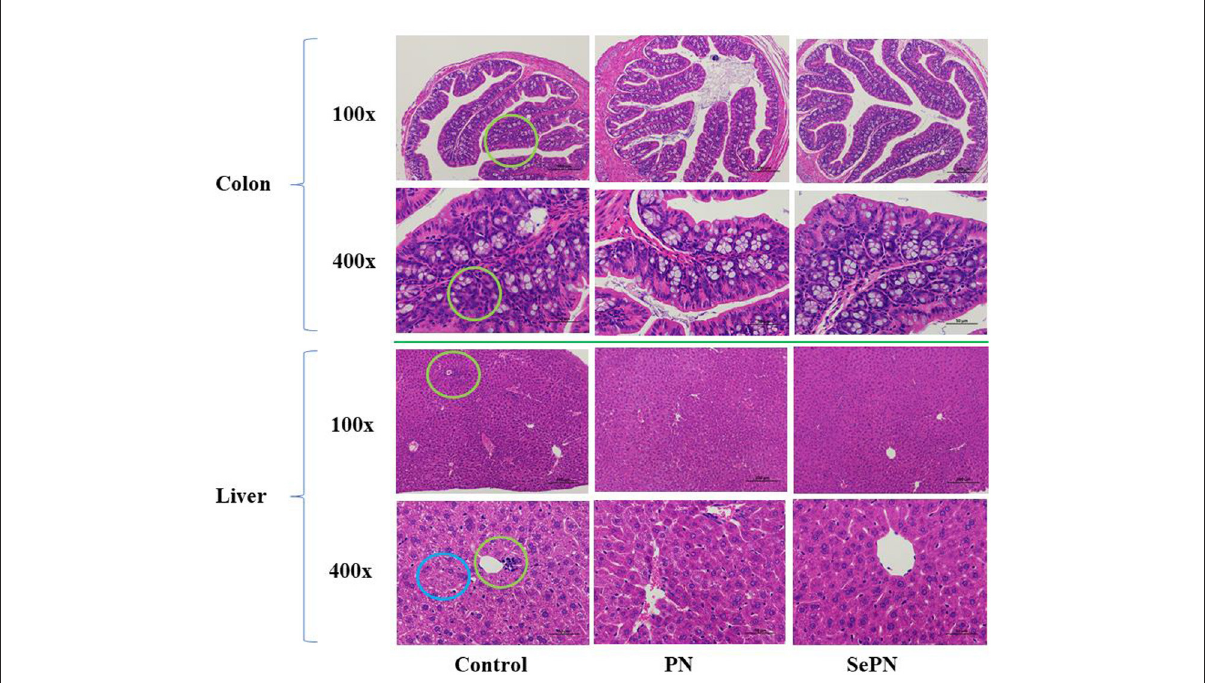
FIGURE4 Representative images of H&E staining in colon and liver sections. We use green circles to indicate inflammatory cell infiltration and blue circles to indicate cell